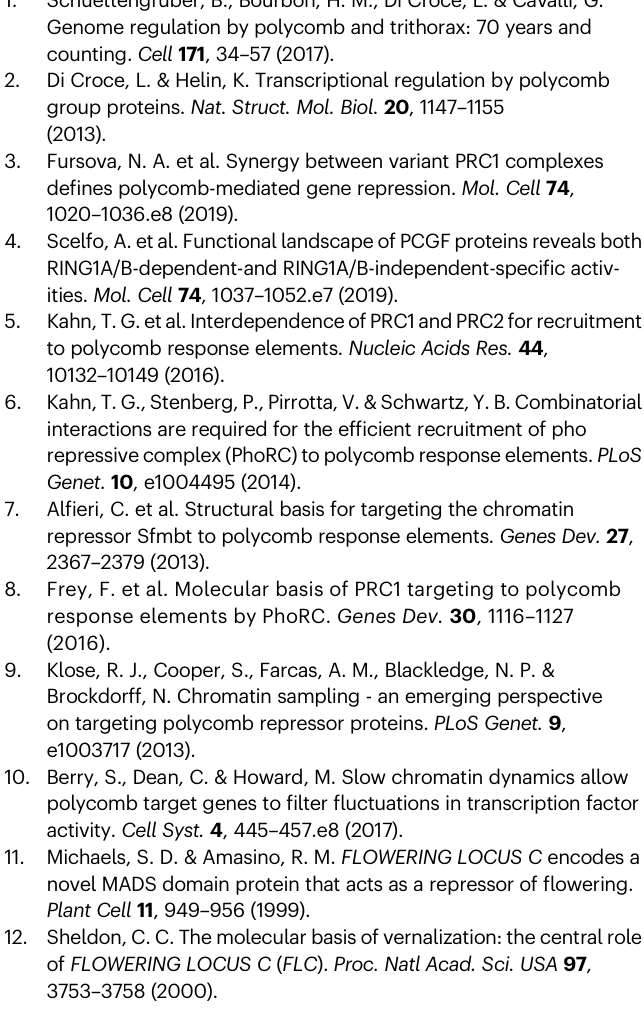
Table 2. Ct values in mobile nucleosome fraction were normalized to uncut